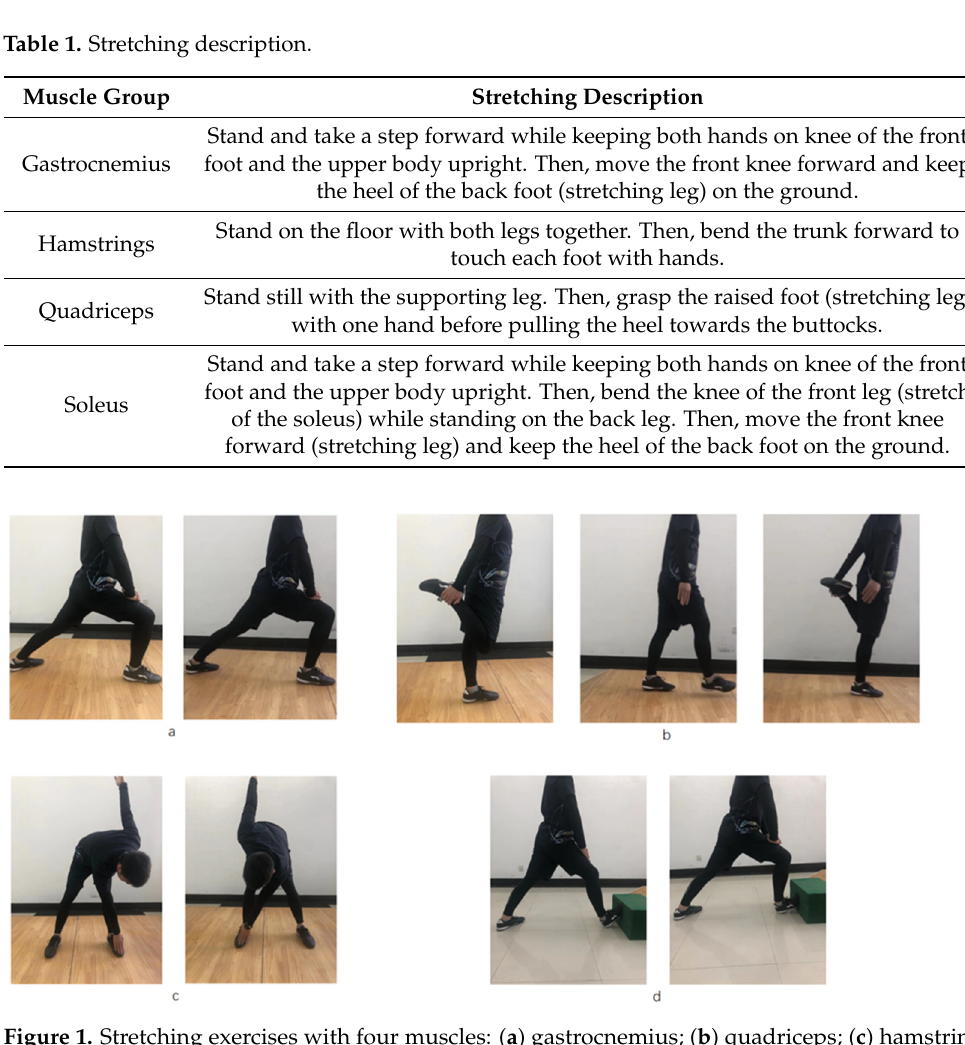
Figure 1. Stretching exercises with four muscles: ( a ) gastrocnemius; ( b ) quadriceps; ( c ) hamstring; ( d ) soleus. The regular stretching condition involved muscles ( a – c ) and the soleus stretching condition involved muscles ( a – d ).